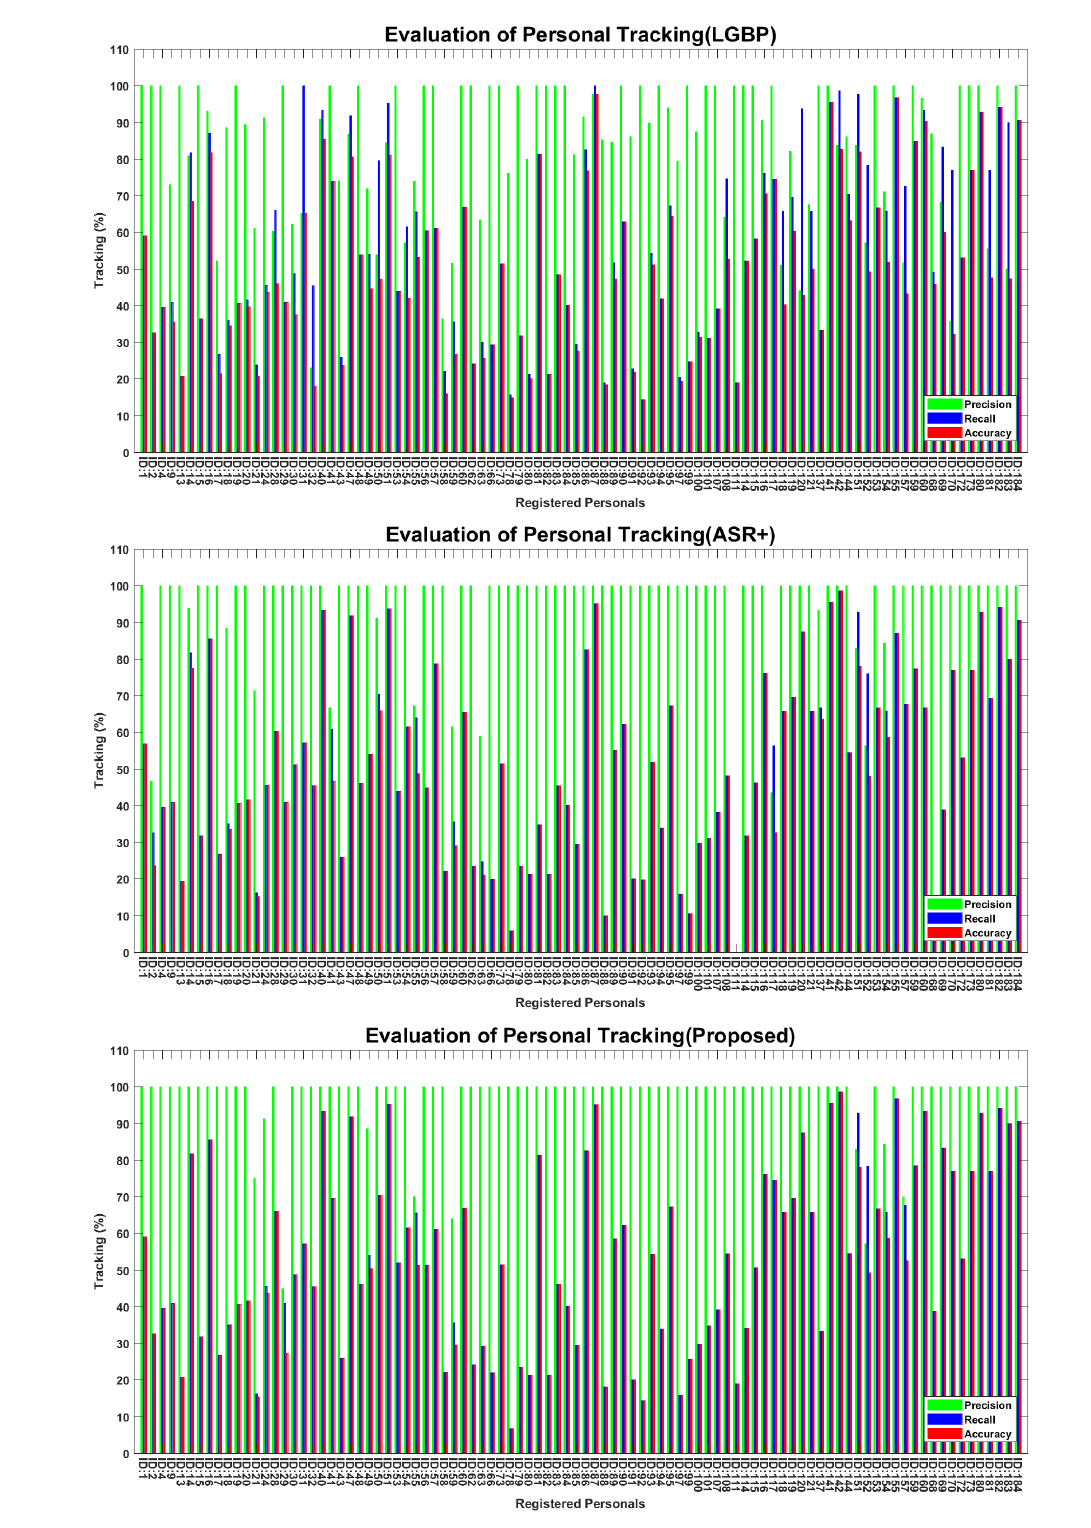
Figure 18. Evaluation of personal tracking in temporal context. Recalls and accuracies were much lower than precisions. Proposed-approach performance was better than individual